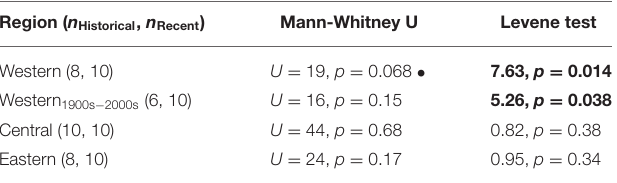
TABLE 4 | Mann-Whitney U and Levene tests between historical and recent female antlers from the Western, Central, and Eastern Coastal Plain. Region ( n Historical , n Recent